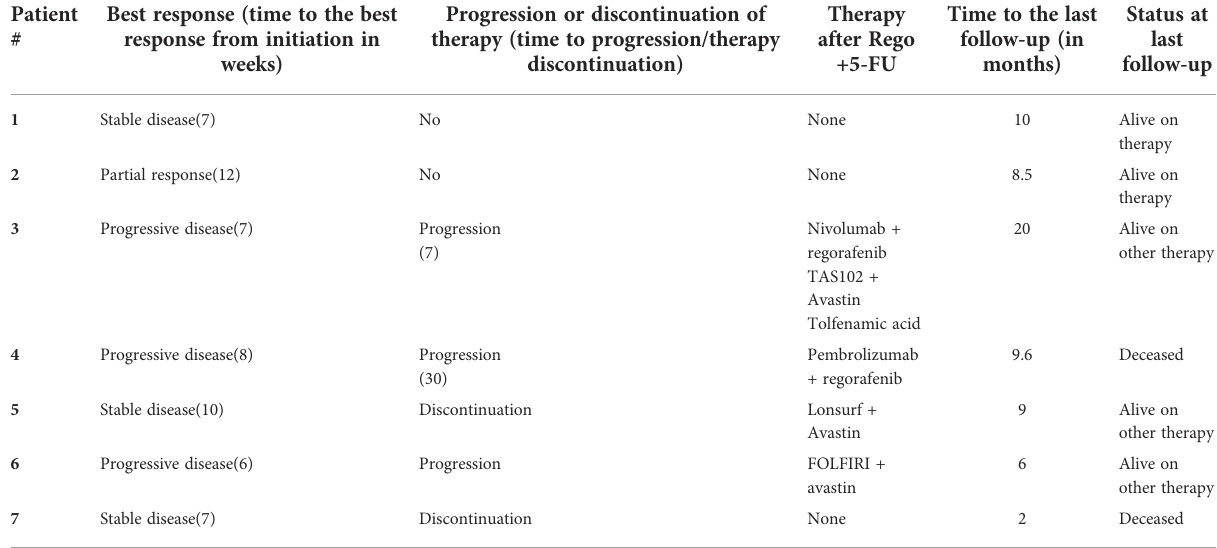
TABLE 2 Outcomes in patients receiving regorafenib and 5-FU.